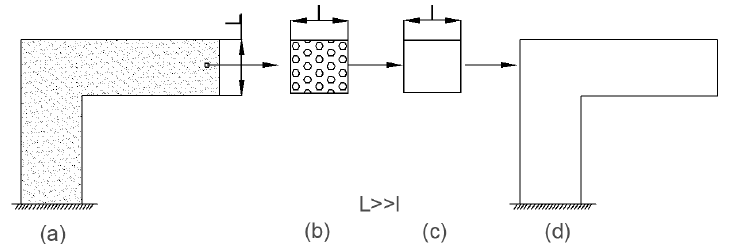
Figure 3. Composite structure, representative unit and equivalent structure (The diagram illustrates the relationship between the three). ( a ) Composite structure; ( b ) The local element; ( c ) Representative volume element; ( d ) The equivalent structure after